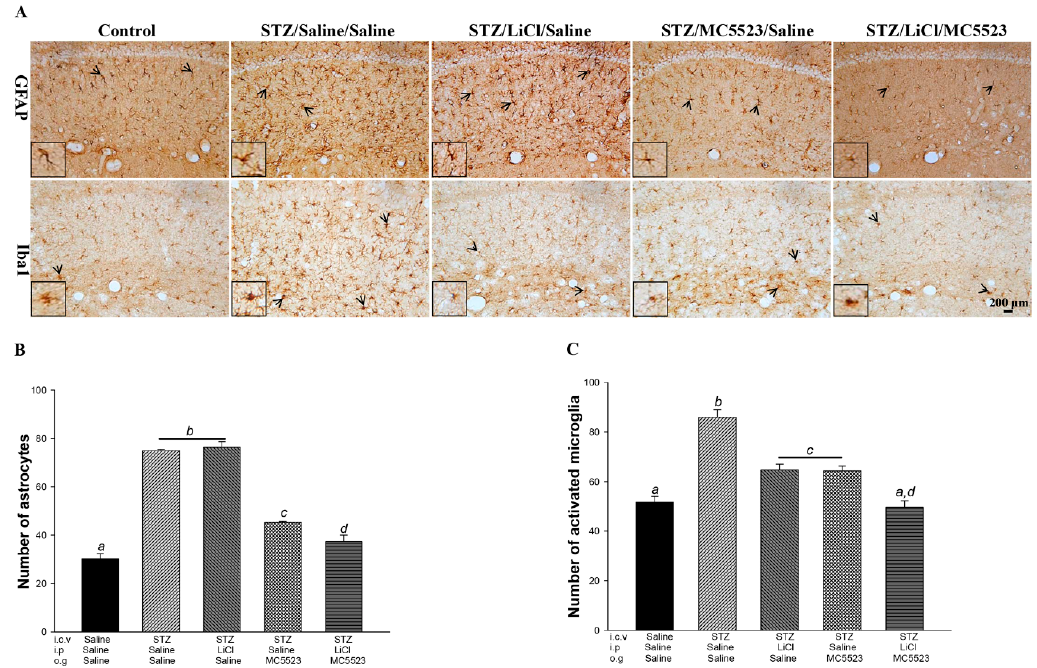
Figure 3. MC5523 greatly decreased the level of gliosis in LiCl-treated icv-STZ OVX 3×Tg-AD mice. (A) Representative images of astrocytes (with glial fibrillary acidic protein (GFAP) staining) and microglia (with Iba1 staining) in the hippocampus. Scale bar = 200 µm. Arrowheads indicate